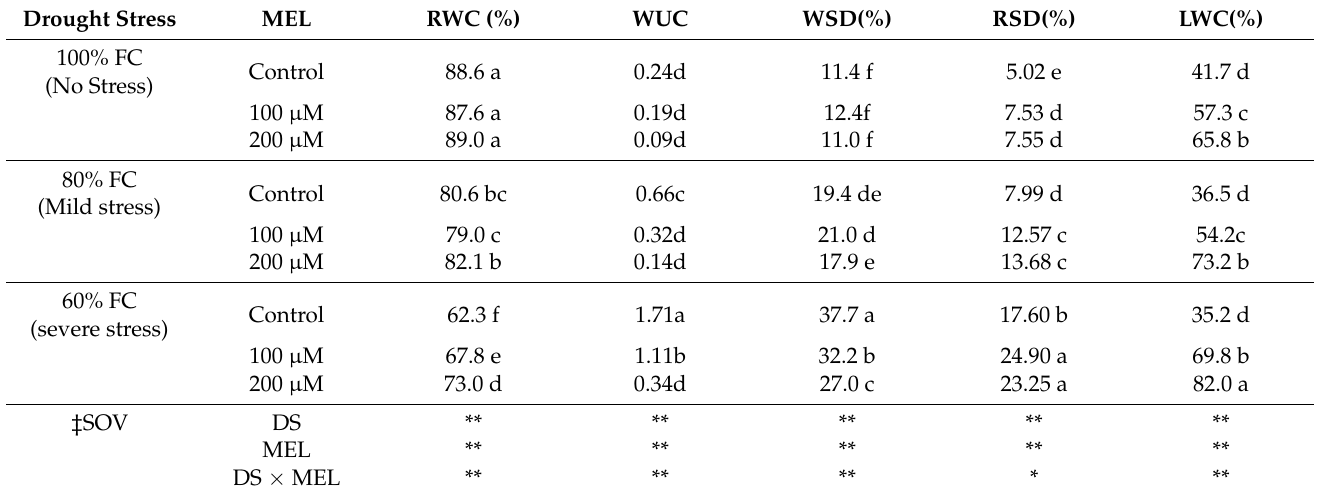
Table 1. Leaf relative water content (RWC%), water uptake capacity (WUC), water saturation deficit (WSD%), relative saturation deficit (RSD%), and leaf water Content (LWC%) of maize as affected by root application of MEL under drought stress. Values in parenthesis represent standard error of